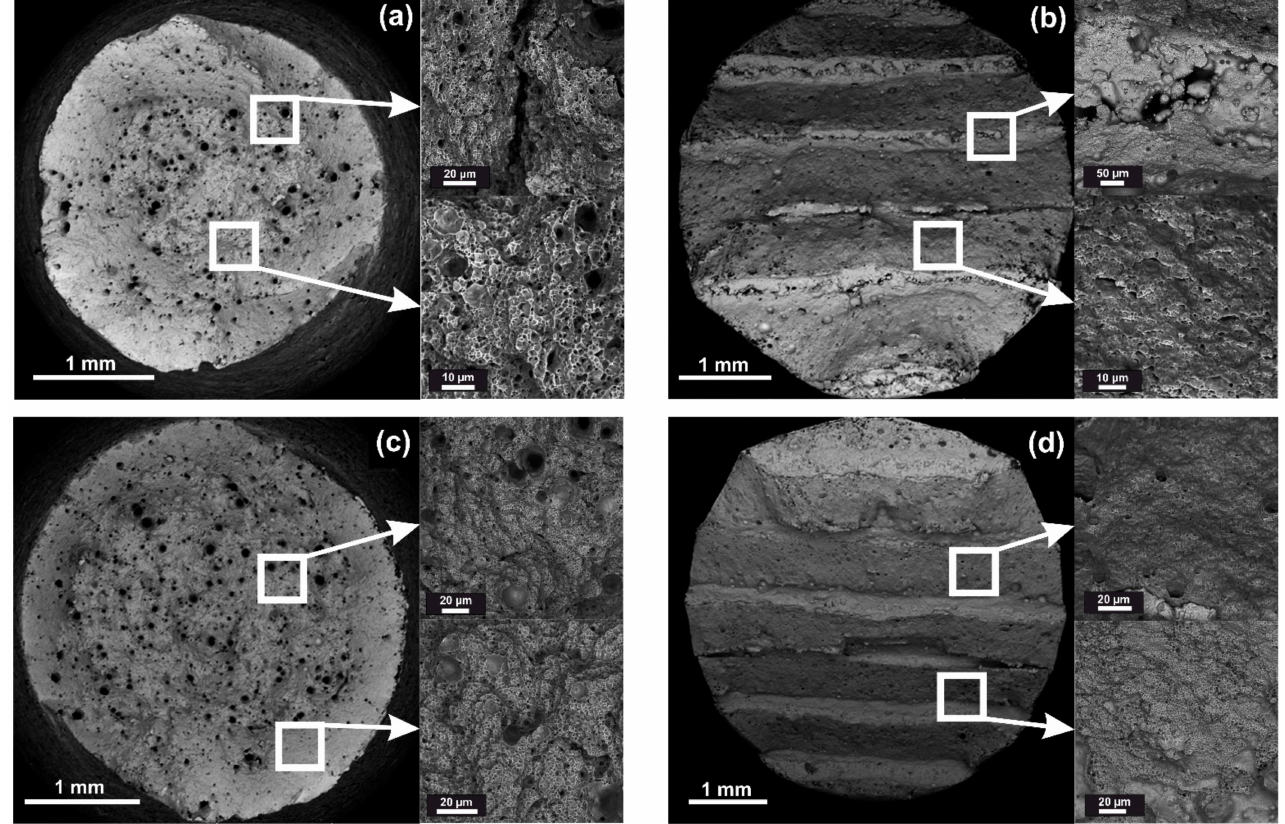
Figure 5. Fracture fractograms after tension of steel 09CrNi2MoCu: ( a ) Initial state after DLD (X orientation); ( b ) initial state after DLD (Z orientation); ( c ) Mode 1, DLD + HT (X orientation); ( d ) Mode 1, DLD + HT (Z